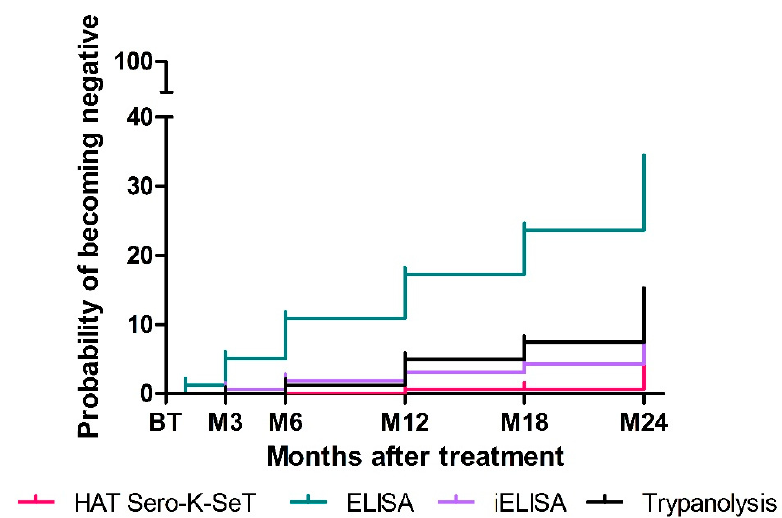
Figure 1. Kaplan–Meier curves displaying the sero-reversion probabilities by each serological test over a two-year follow-up period, expressed as percentages.